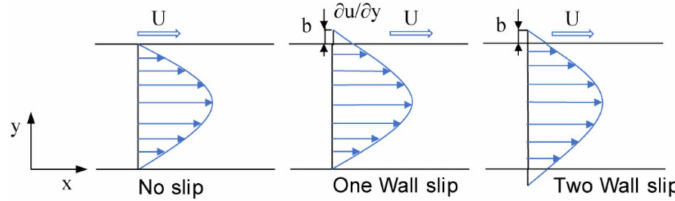
Figure 2. Slip length on an immersed slippery